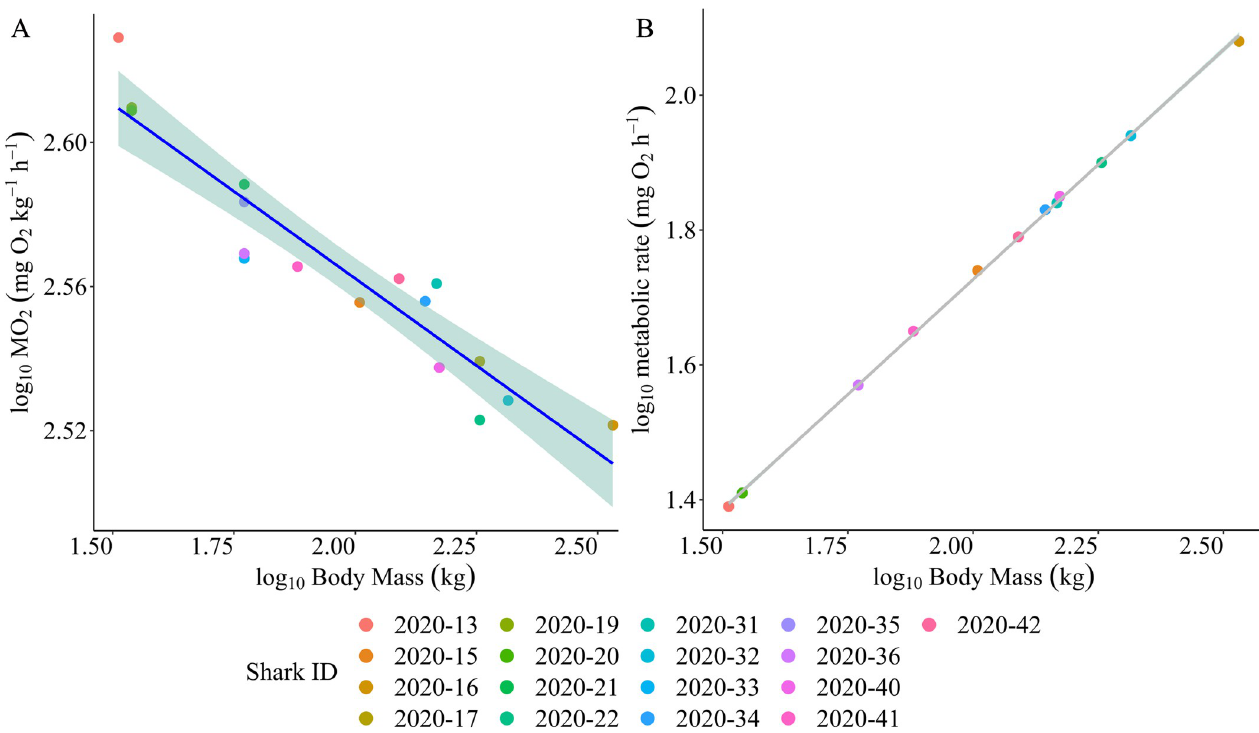
Fig 4. Metabolic implications of measured swimming speeds and body size in juvenile white sharks. (A) Estimated mass-specific mean fRMR of juvenile white sharks in the study. Points and trend-lines show mean estimated oxygen consumption rates of all sharks included in analyses, with respect to body size (mass), based on the general equation furnished by Semmens et al. (2013). Shaded areas delineate 95% confidence intervals associated with conditional smoothed mean values. (B) Whole-body routine metabolic rates (mean 420 ± 51mg O 2 h − 1 ) based upon the allometric mass-scaling exponent of 0.79, as described by Payne et al